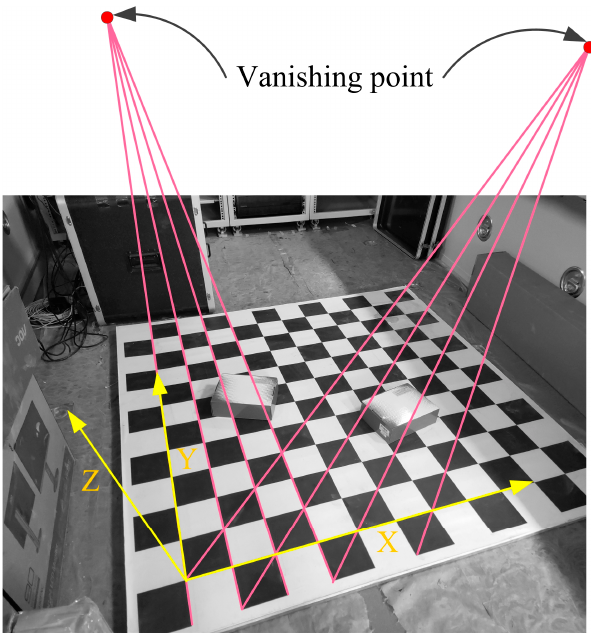
Figure 10. Two vanishing points were extracted for the focal length and pose estimation.